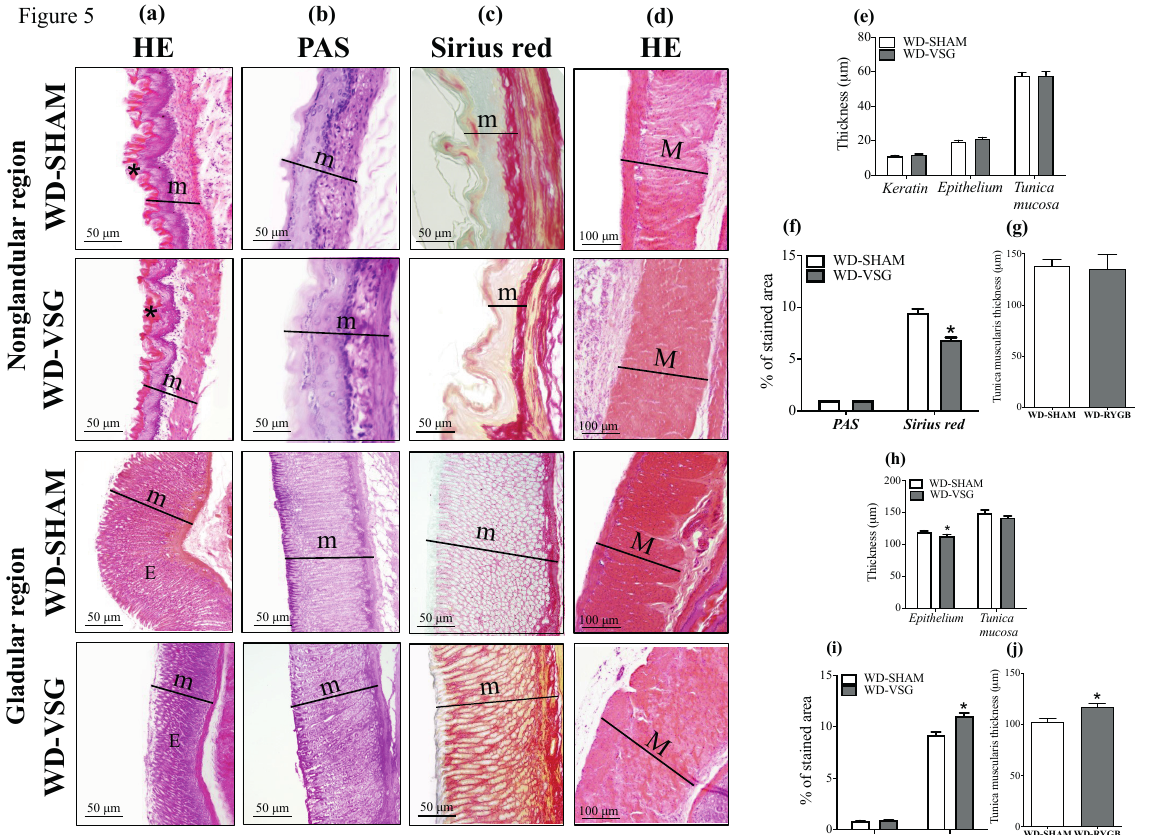
Figure 5. Representative images of 5-μm-thick sections of the non-glandular and glandular regions of the stomachs of WD-SHAM and WD-VSG rats, at 3 months after operations. Sections were stained with HE (a and d; * = keratin layer; E = epithelium layer; m = tunica mucosa; M = tunica muscularis), or periodic acid Schiff (PAS; b; m = tunica mucosa) or sirius red (c; m = tunica mucosa). Scale bars = 50 or 100 μm. Means ± SEM of the thickness of keratin and epithelium layers, and tunica mucosa (e and h), percentage of PAS or Sirius red (f and i) positive areas in tunica mucosa, and the thickness of the tunica muscularis (g and j), of nonglandular and glandular regions, respectively, in the stomach of WD-SHAM (n = 5) and WD-VSG (n = 5) rats. *different from WD-SHAM (Mann Whitney U-test, P <